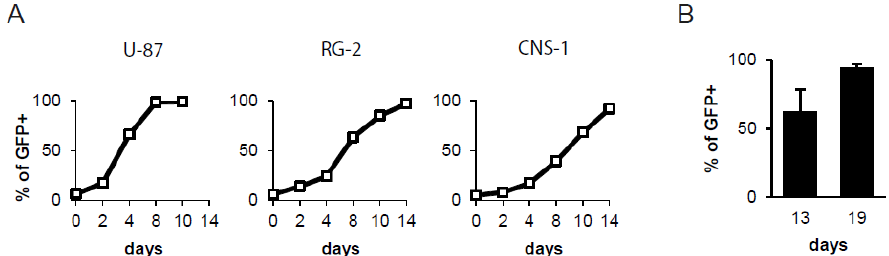
Figure 2. Replicative spread of GS4-GFP in glioma cells in culture and in intracerebral gliomas in vivo. ( A ) GS4-GFP-transduced RG-2 cells (5%) and uninfected RG-2 cells (95%) were mixed and seeded onto culture plates. At various time points after cell mixing, the cell populations were analyzed for GFP expression. X-axis: days after cell mixture. Y-axis: % of cells expressing GFP. ( B ) GS4-GFP (2 × 10 4 TU) was injected into a pre-established intracerebral RG-2 tumor model in Fischer 344 rats. The